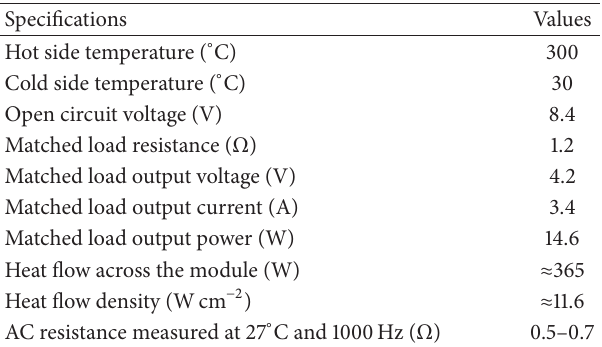
Table 1: Specification of TEM